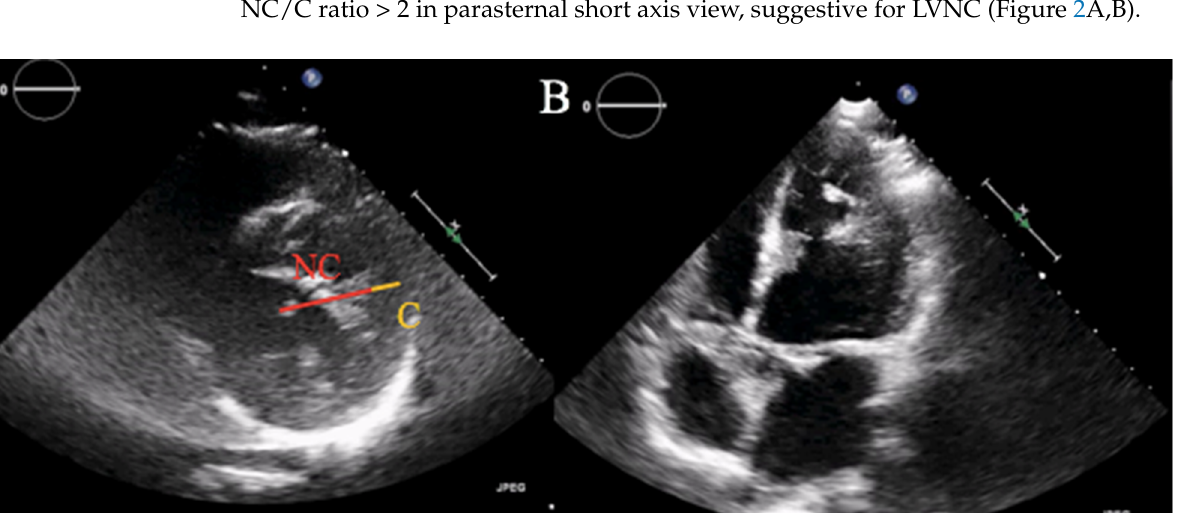
Figure 2. Transthoracic echocardiogram. ( A ) Parasternal short axis view showing an end systolic NC/C ratio >2, diagnostic for LVNC according to Jenni’s criteria. ( B ) Apical four chambers view with evidence of hypertrabecular appearance of the left ventricle at the apex and lateral wall.